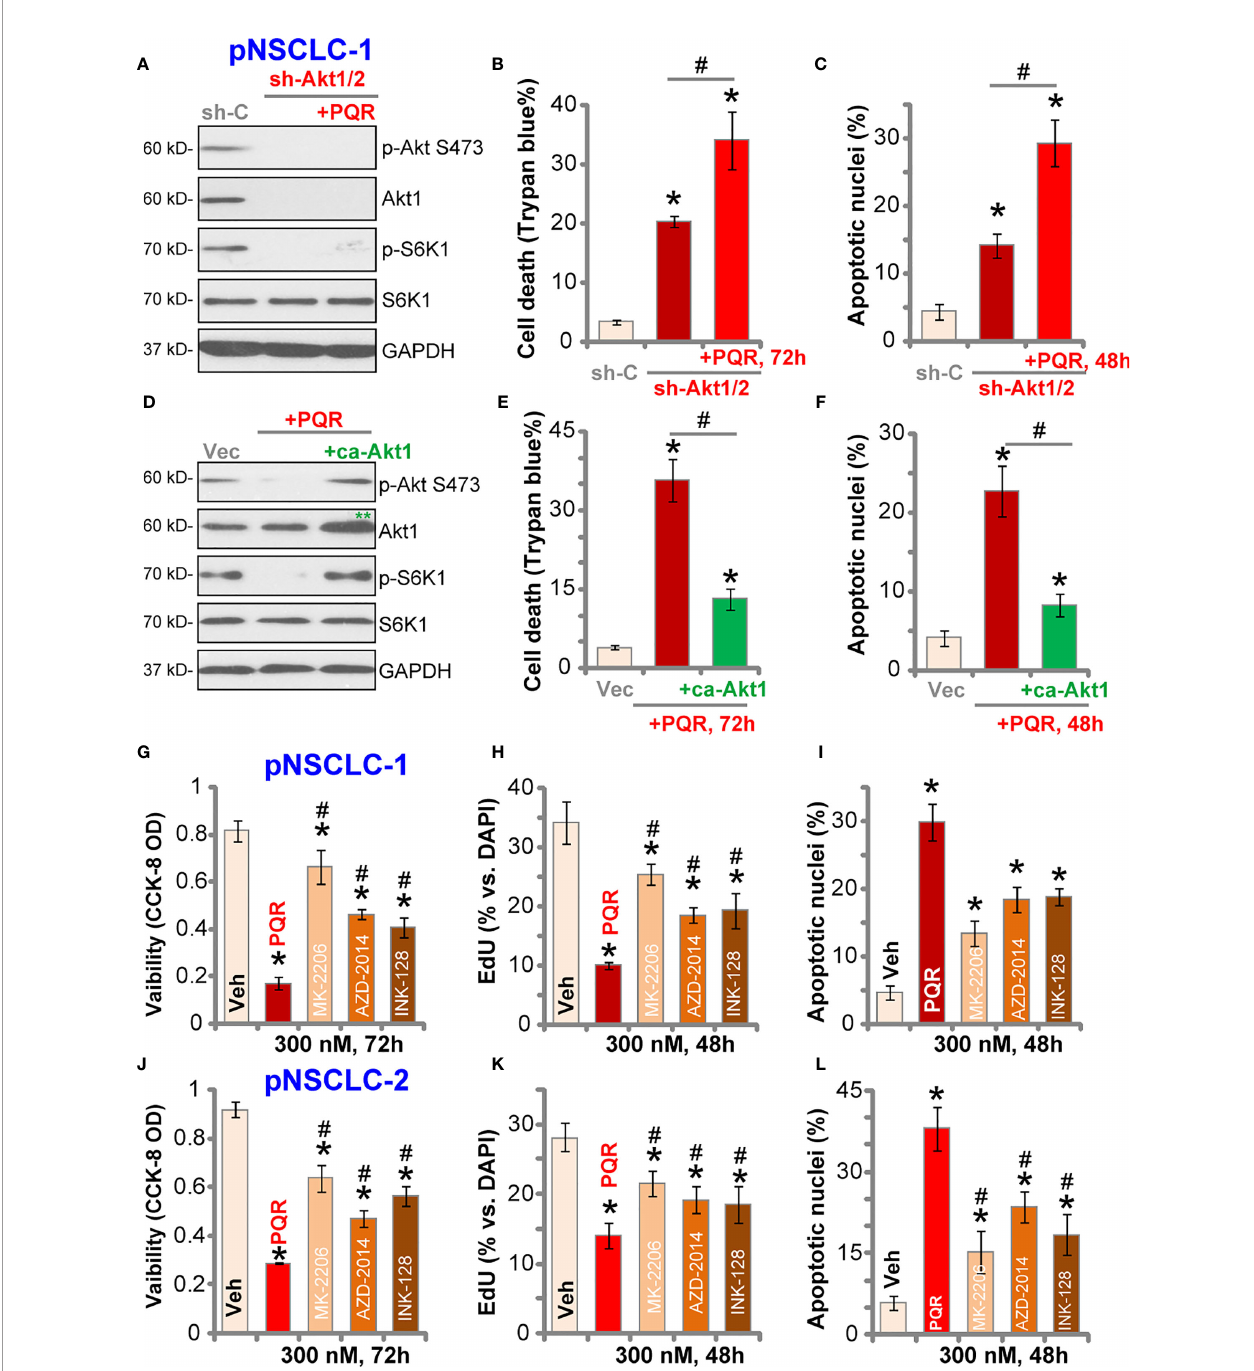
FIGURE 4 | PQR620-induced anti-NSCLC cell activity is not solely dependent on Akt-mTOR inhibition. Stable pNSCLC-1 cells expressing Akt1/2 shRNA (sh-Akt1/ 2) were treated with or without PQR620 ( “ PQR ” , 300 nM), and control cells were treated with scramble control shRNA (sh-C). Cells were further cultured for applied time periods, and expression of listed proteins was shown (A) Cell death and apoptosis were tested by Trypan blue (B) and apoptotic nuclei (C) staining assays, respectively. Stable pNSCLC-1 cells expressing constitutively-active Akt1 (ca-Akt1, S473D) were treated with or without PQR620 ( “ PQR ” , 300 nM), and control cells were transfected with empty vector (Vec). Cells were further cultured for applied time periods, and expression of listed proteins was shown (D) Cell death (E) and apoptosis (F) were tested similarly. pNSCLC-1 (G – I) and pNSCLC-2 cells (J – L) were treated with 300 nM of PQR620 ( “ PQR ” ), MK-2206, AZD-2014 or INK-128 for applied time periods. Cell viability, proliferation, and apoptosis were tested by CCK-8 assay (G , J) , nuclear EdU staining (H , K) , and apoptotic nuclei staining (I , L) assays, respectively. Data were presented as mean ± standard deviation (SD, n=5). * p < 0.05 vs. “ shC ” / ” Vec ” / ” Veh ” cells. # p < 0.05 (B , C , E , F) . # p < 0.05 vs. PQR620 treatment (G – L) . Experiments were repeated fi ve times with similar results